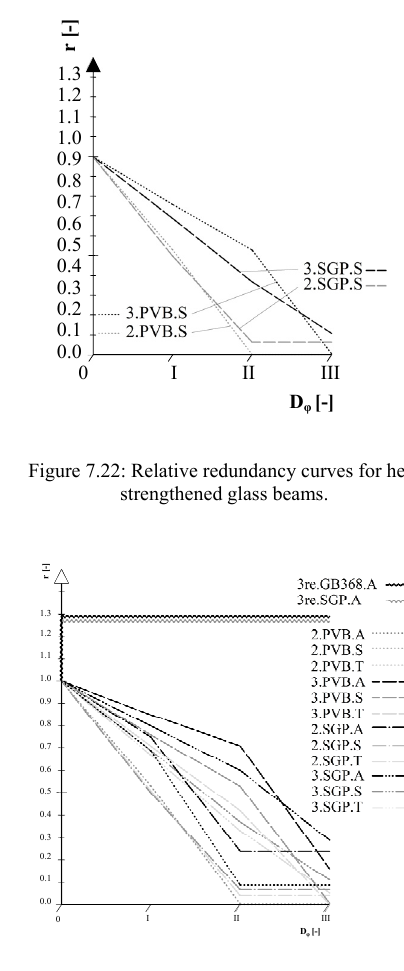
Figure 23: Relative redundancy curves for thermally tempered glass beams.